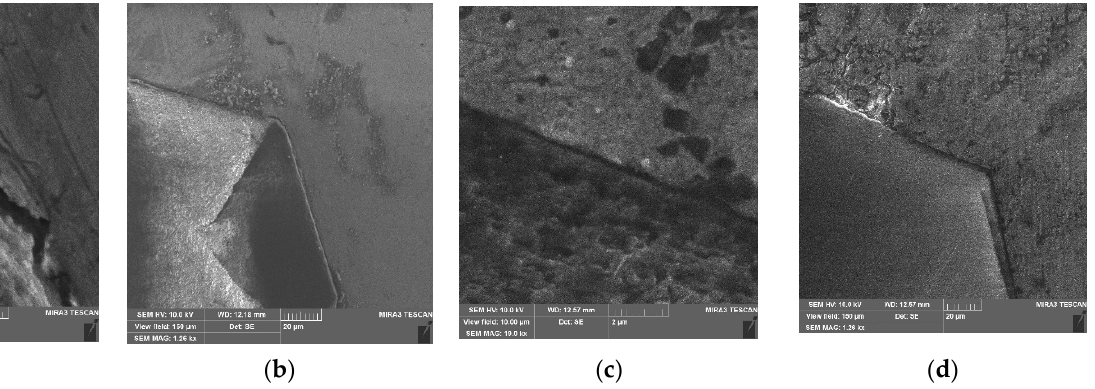
Figure 1. SEM image of polished surface of diamond matrix samples based on 51Fe–32Cu–9Ni–8Sn matrices with different contents of nano-VN additive: ( a ) and ( b ) Sample 1 without VN addition; ( c ) 8Sn matrices with different contents of nano-VN additive: ( a , b ) Sample 1 without VN addition; and ( d ) Sample 5 with 2 wt.% of nano-VN. ( c , d ) Sample 5 with 2 wt.% of